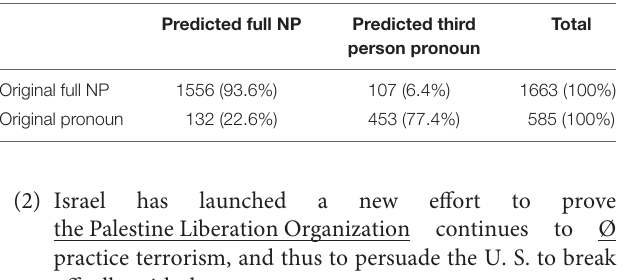
TABLE 6 | Confusion matrix for the boosting algorithm, basic referential choice.